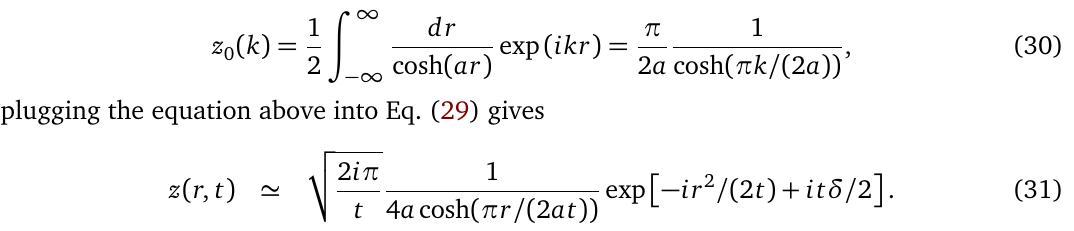
x - y lane) varying as ϕ ( r , t ) = − r 2 / ( 2 t ) + t δ/ 2. This is in agreement with the data plotted in Fig. 4 (bottom panel) for ∆ = 1 ( δ = 0) or Fig. 5 at ∆ =